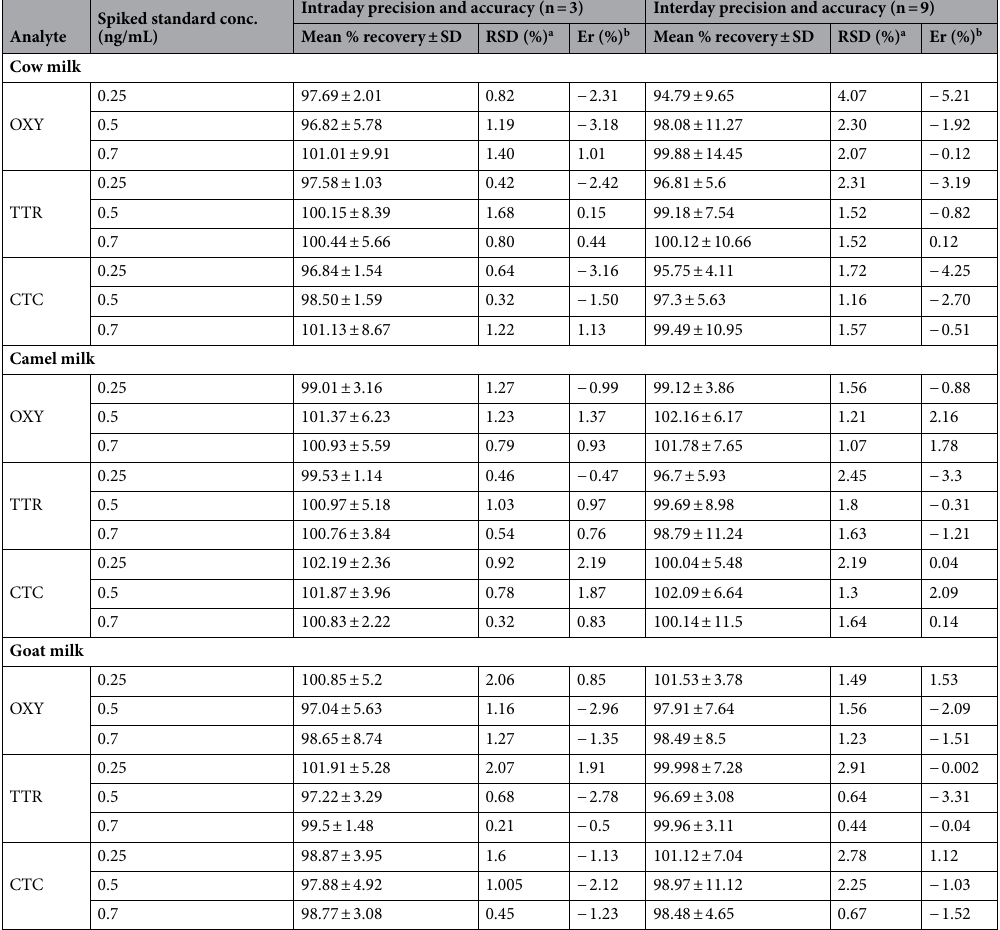
Table 5. Accuracy and precision of the method in each milk matrix. a RSD (%) Percentage relative standard deviation. b Er (%) Percentage relative